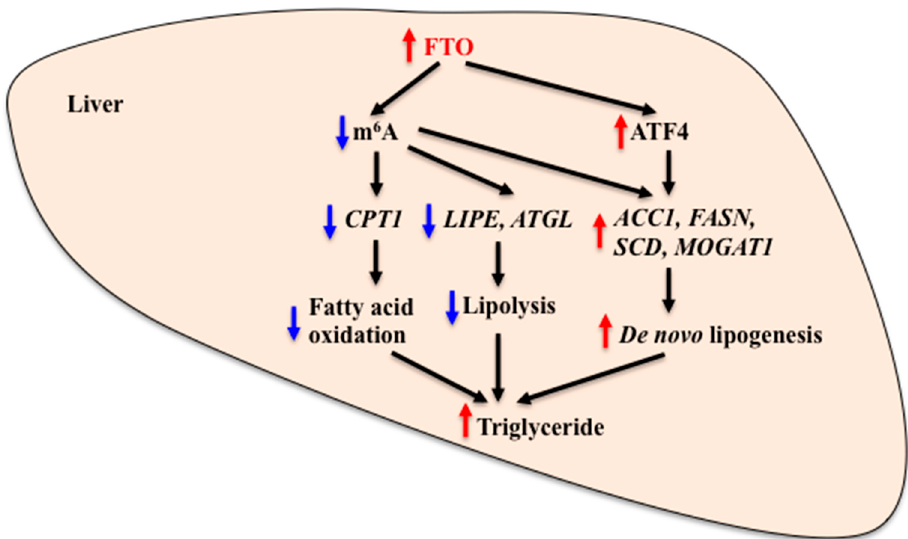
Figure 3. Role of FTO in the regulation of hepatic lipid metabolism. FTO regulates hepatic lipid metabolism by altering the methylation state of genes that are involved in fatty acid oxidation, lipolysis and de novo lipogenesis. FTO also regulates hepatic lipid metabolism by altering the activity of transcription factors. Increased FTO expression and/or activity causes a reduction of m 6 A levels and reduces CPT1 , LIPE and ATGL mRNA expression, leading to reduced fatty acid oxidation and lipolysis. It also causes an increase in ATF4 expression, which then stimulates expression of lipogenic genes, leading to increased de novo lipogenesis in the liver. Reduced FTO expression and/or activity causes the opposite effect. FTO: Fat mass and obesity-associated, m 6 A: N 6 -methyladenosine, CPT1: